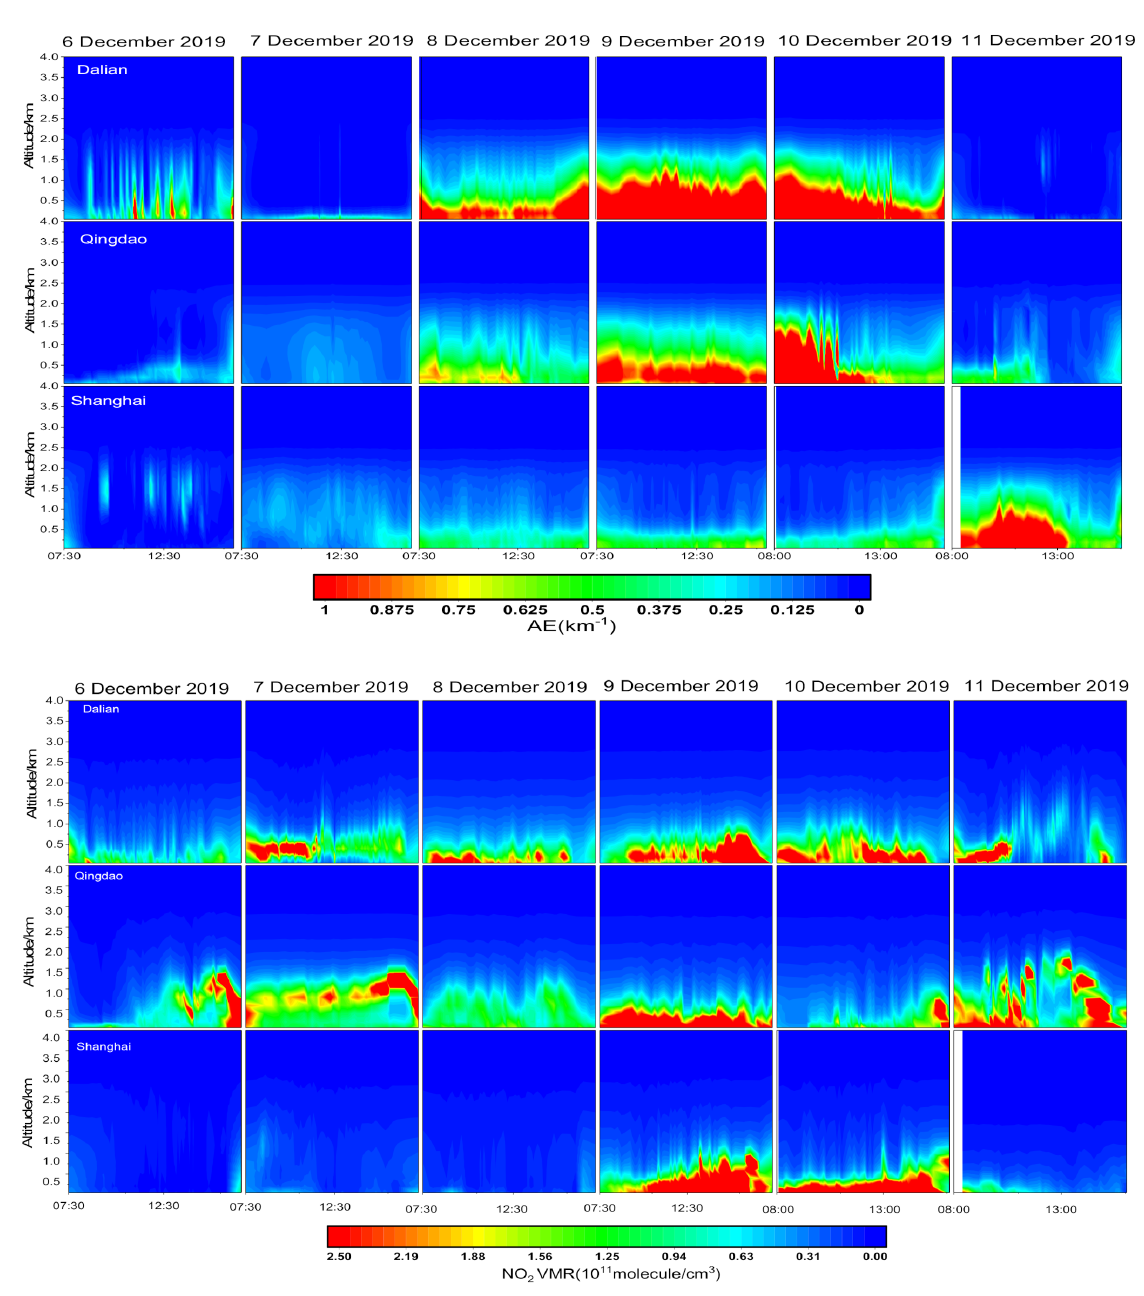
Figure 11. AOD and NO 2 profiles in Dalian, Qingdao, and Shanghai from 6 December 2019 to 11 December